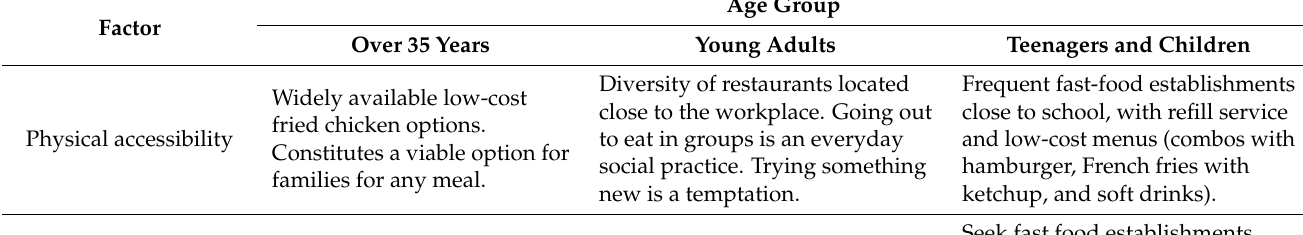
Table 2. Decisive factors in the selection of the dining establishment by age group reported by the key informants.